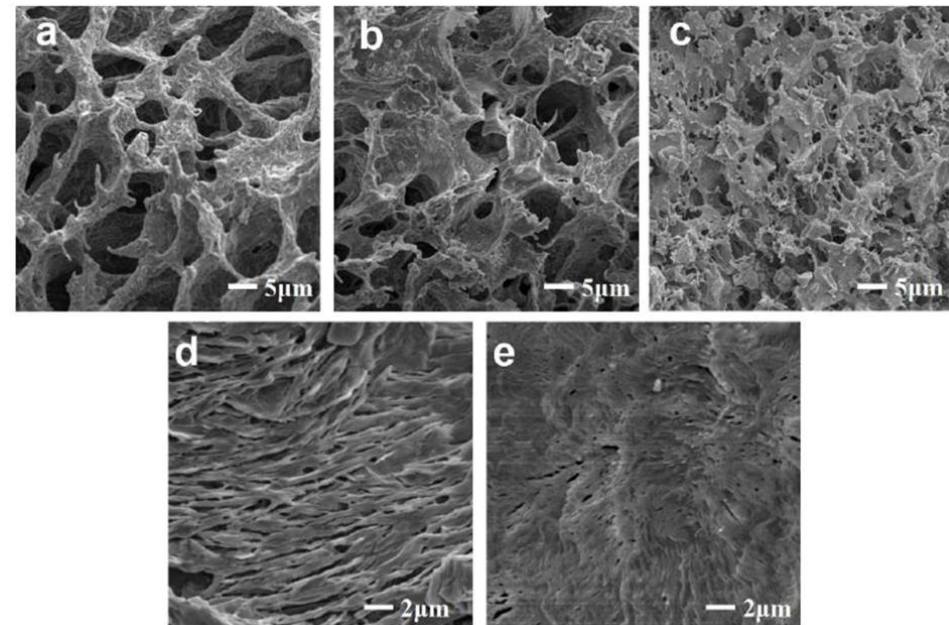
Figure 5. Scanning electron microscopy (SEM) images of ( a ) pure chitosan (CS)-based hydrogels; ( b ) CS-based hydrogels crosslinked with polyvinyl alcohol (PVA) hydrogels; ( c ) CS-based hydrogels crosslinked with glutaraldehyde (GLA); ( d ) CS-based hydrogels crosslinked with GLA and PVA; ( e ) PTX–cyclodextrin (PTX-CD) complexes embedded in CS-based hydrogels crosslinked with GLA and PVA. Reproduced with permission from [146], Elsevier